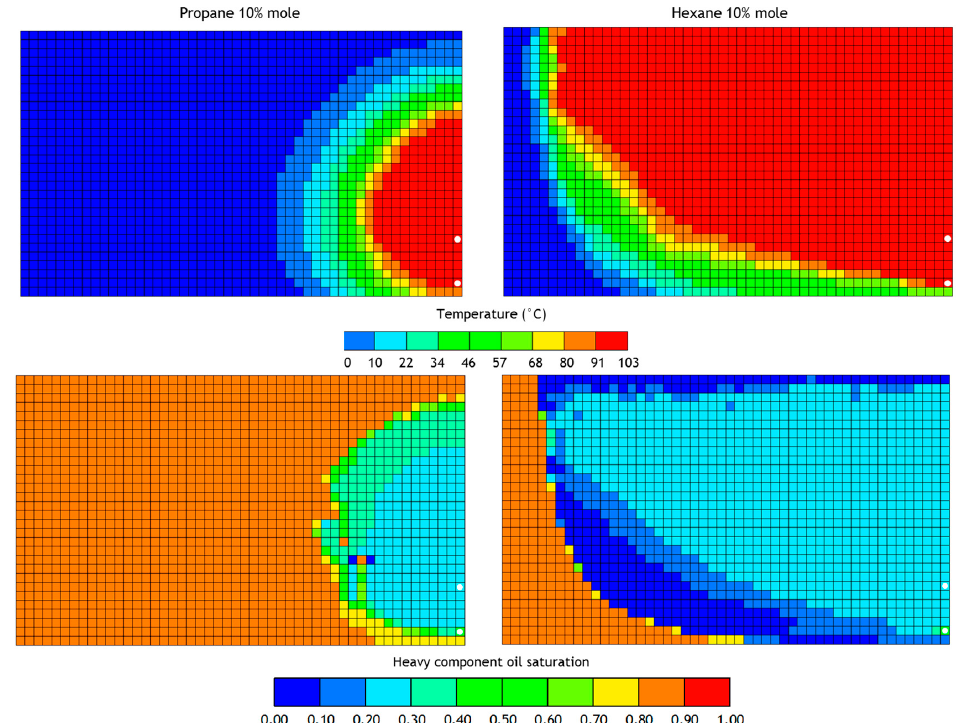
Figure 9. Temperature and heavy component saturation in the oil phase distribution after five years of simulation for two ES-SAGD processes in which hexane and propane were co-injected at 10% mole. Hexane co-injection shows a bigger steam chamber after five years which leads to a higher oil recovery compared to the propane co-injection.